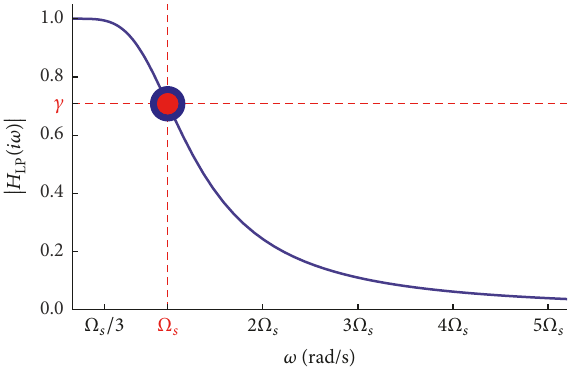
Figure 8: The required filter frequency response